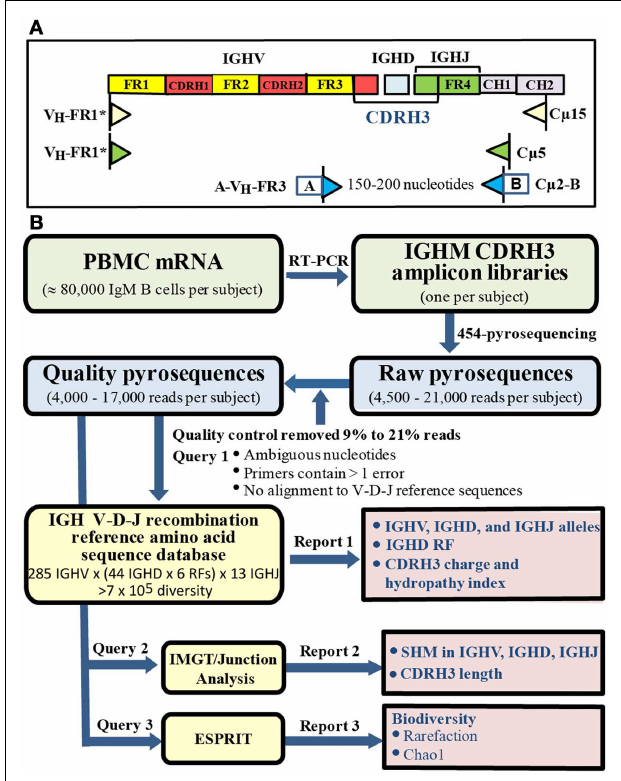
FIGURE 1 |Amplicon libraries and bioinformatic pipeline . (A) Library construction. IgM specificity was determined by reverse primers sequences specific for IgM constant region without IgM B cell purification. (B) Bioinformatic pipeline. Quality sequences (blue box) were analyzed by querying: (1) customized IGHV-D-J recombination reference sequence database, (2) IMGT/Junction Analysis, (3) ESPRIT (yellow boxes)